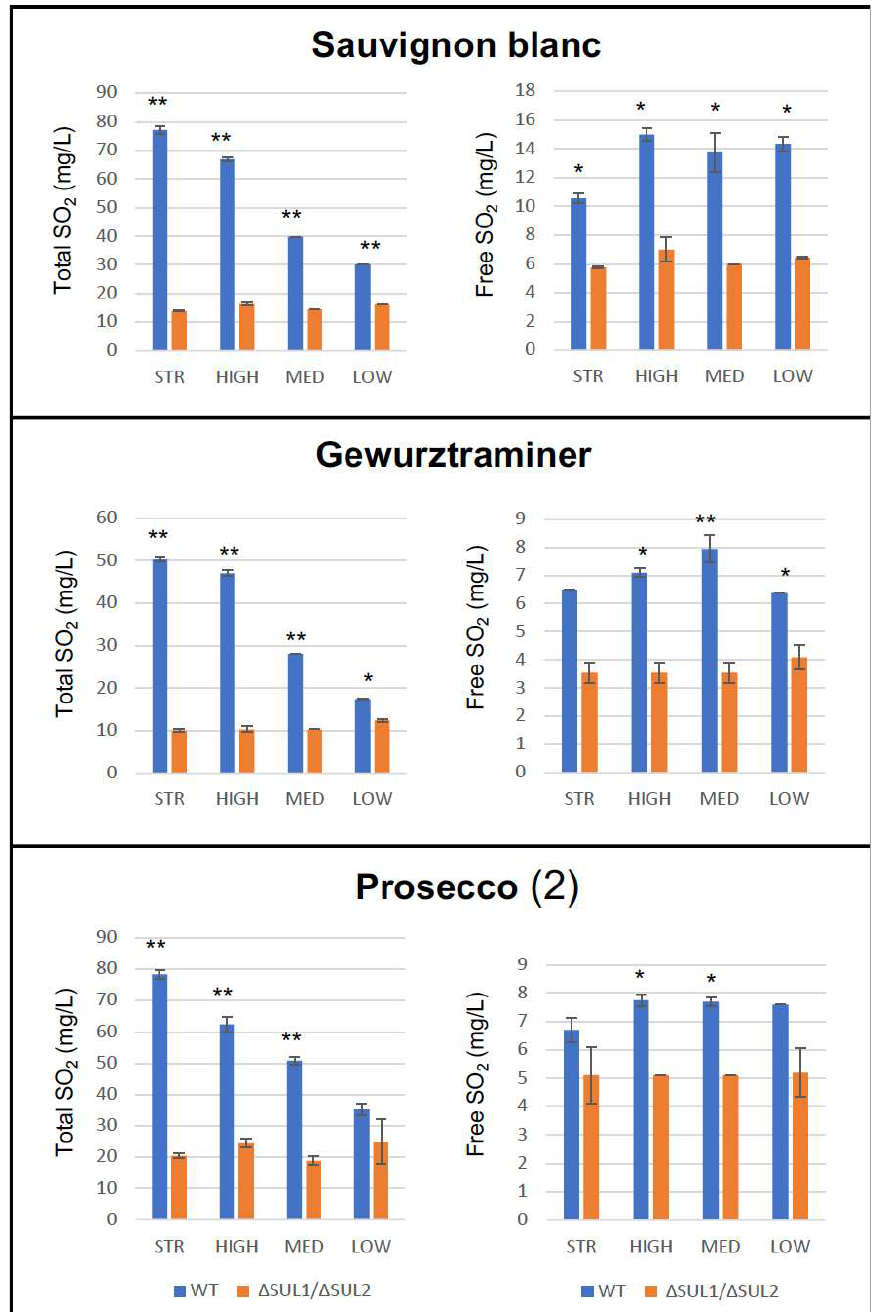
Figure 8. Total and free SO 2 production by winery yeast strains in different fermentation substrates. Parental (WT, blue bars) and double mutant ( ∆ SUL1 / ∆ SUL2 , orange bars) cells of the indicated strains (STR, HIGH, MED, and LOW) have been used to perform fermentation assays in natural grape musts of different types (“Sauvignon”, Gewurztraminer”, and “Prosecco 2”). Diagrams report the final amounts of total (left panels) and free SO 2 (right panels) produced by the yeast strains. Values are expressed as the mean ± S.D. ( n = 2). * p -value < 0.05; ** p -value < 0.01, unpaired Student’s t-test.